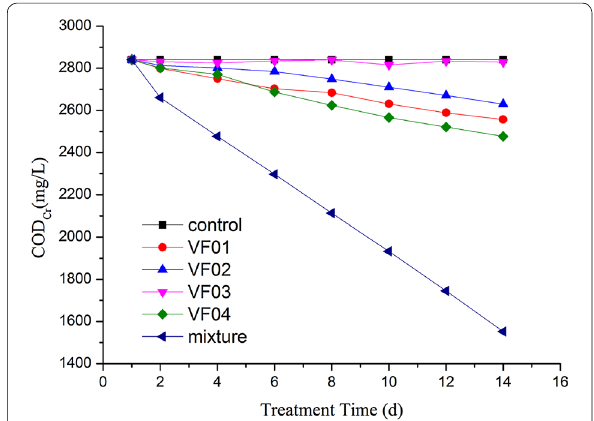
Fig. 5 Biodegradation of COD Cr by mixture of the four isolates, the consortium VF, and mixture the consortium +